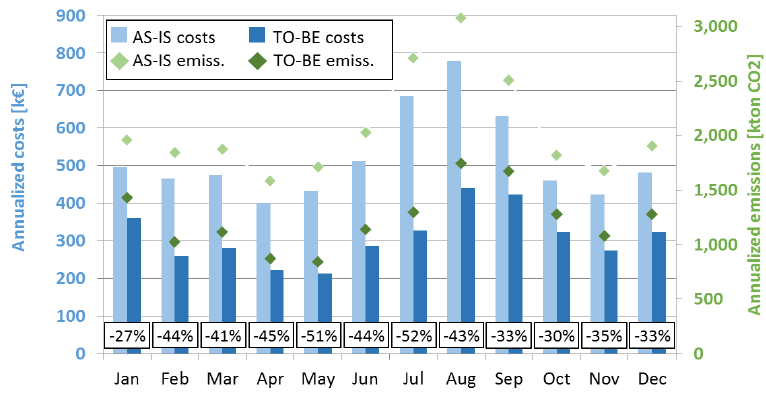
Figure 20. Monthly economic and emission saving in the TO-BE scenario 2 compared to the AS-IS scenario.